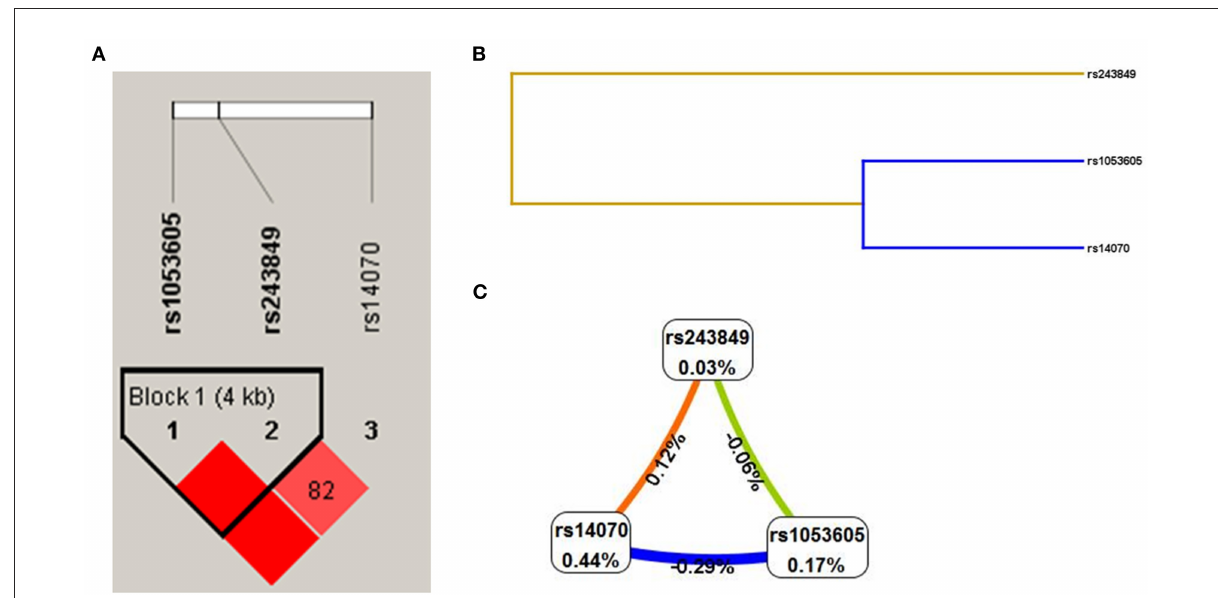
FIGURE2 Genetic association between 3 SNPs (rs1053605, rs243849 and rs14070) in MMP2 . (A) LD results of 3 SNPs in MMP2. (B) SNP-SNP interaction dendrogram of MDR analysis. (C) Fruchterman-reingold of MDR analysis (The closer to red the stronger the synergy, the closer to the blue the more redundancy).